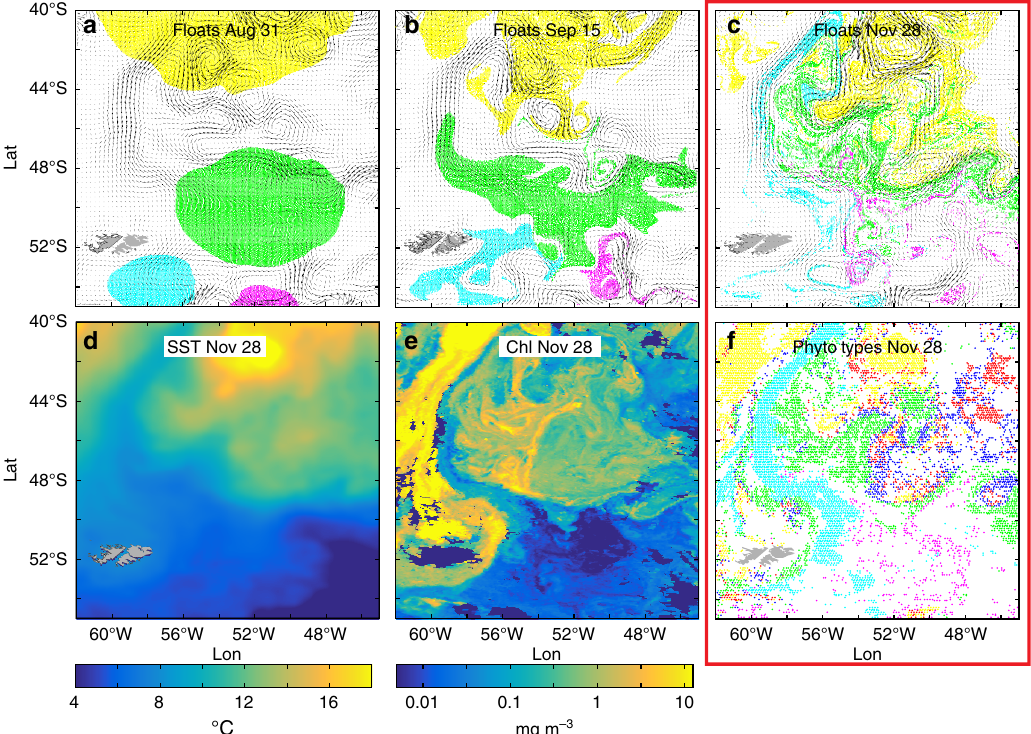
Fig. 2 Horizontal stirring. a , b and c Model: virtual numerical fl oats advected horizontally by altimetry-derived AVISO mesoscale surface currents (arrows) from 31 August to 28 November, 2001, at the con fl uence of the Brazil and Malvinas currents. The currents have a nominal space – time resolution of 1/3° and one week. Floats, colored according to their original patch location on August 31, form, by November 28, small-scale tendrils through stirring by the time-evolving mesoscale fl ow. d , e and f Satellite data: d sea surface temperature, e chlorophyll, and f phytoplankton types. Chlorophyll data from Sea- viewing Wide Field-of-View Sensor (SeaWiFS) at 9 km resolution ( e ) were processed to derive optical products ( f ) representing dominant phytoplankton types (yellow: nanoeukaryotes; green: diatoms; magenta: Phaeocystis ; red: Prochlorococcus ). These types show convoluted patterns, similar to the simulated distributions of the numerical fl oats ( c ). The comparison of the two panels in the red box support lateral mesoscale stirring as a dominant mechanism for generating the patterns of the ecological niches in this region. Adapted from d ’ Ovidio et al.